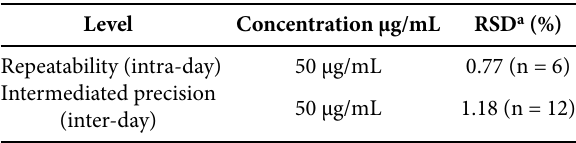
Table 3. Results of intra and inter-day precision for determination of insulin in standard solutions.